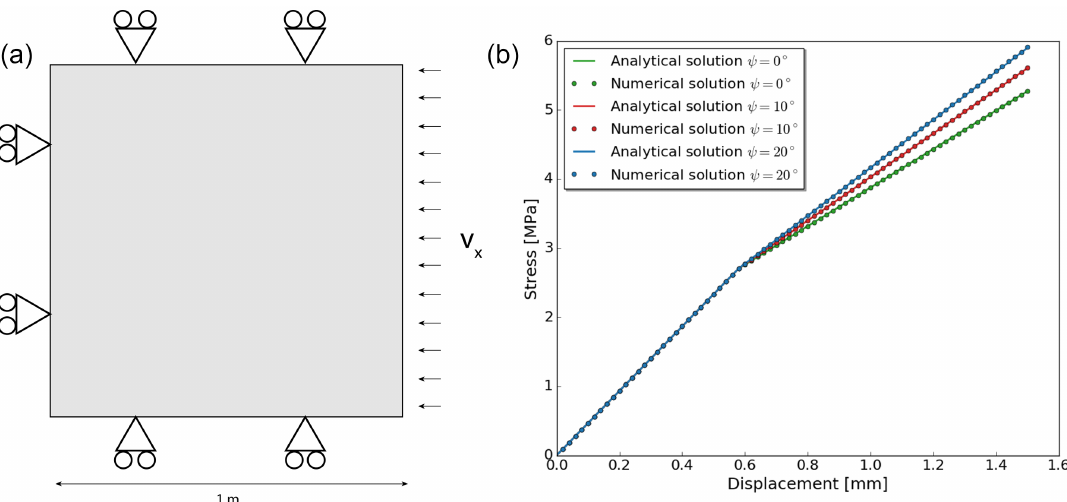
Figure 7. Problem formulation and results of the oedometer benchmark. Panel (a) shows the problem formulation. Panel (b) illustrates the results for different dilation angles with the stress-displacement